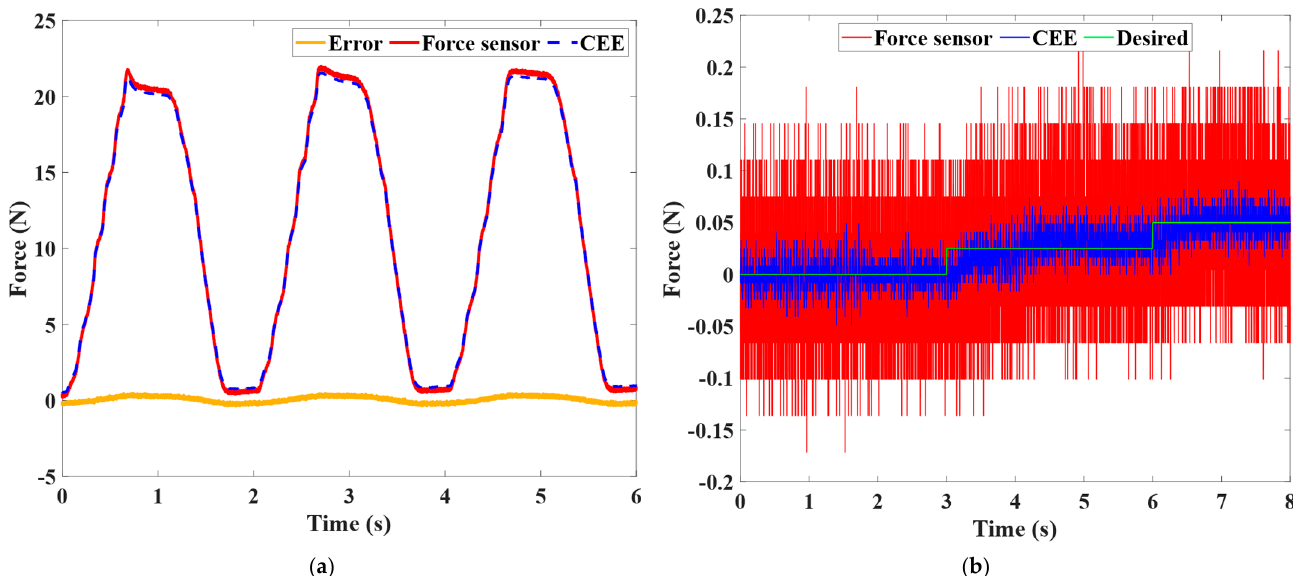
Figure 8. Comparison of contact force obtained by force sensor and CEE: ( a ) consistency of measurement results; ( b ) resolution of contact force.